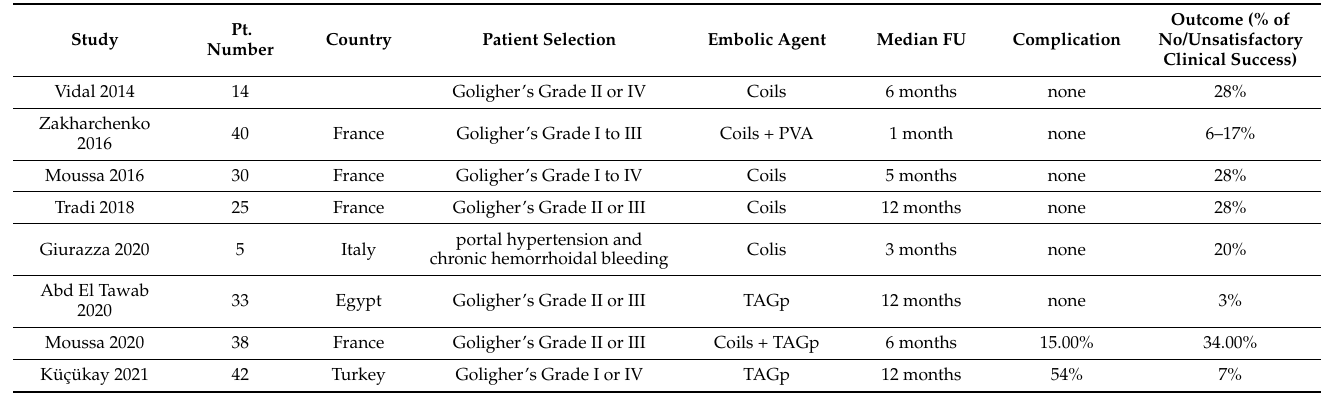
Table 1. Clinical studies